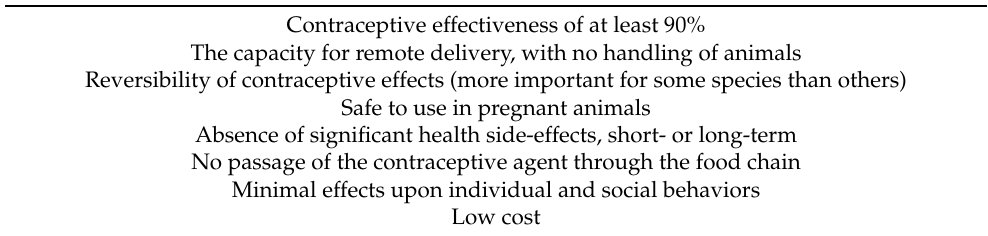
Table 1. Kirkpatrick and Turner’s characteristics of an ideal wildlife contraceptive [1]. Contraceptive effectiveness of at least 90% The capacity for remote delivery, with no handling of animals Reversibility of contraceptive effects (more important for some species than others) Safe to use in pregnant animals Absence of significant health side-effects, short- or long-term No passage of the contraceptive agent through the food chain Minimal effects upon individual and social behaviors Low